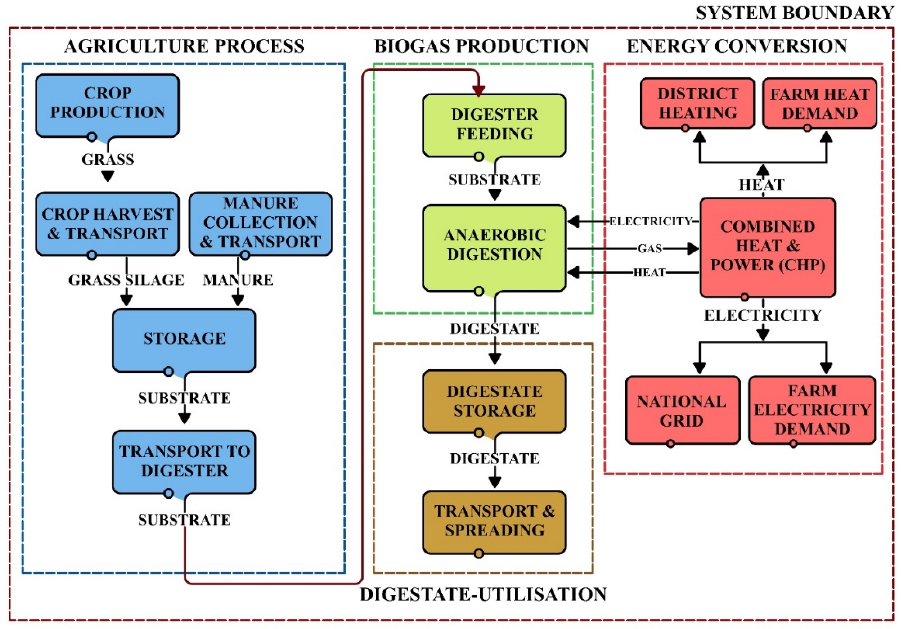
Figure 1. System Figure 1. System boundary.